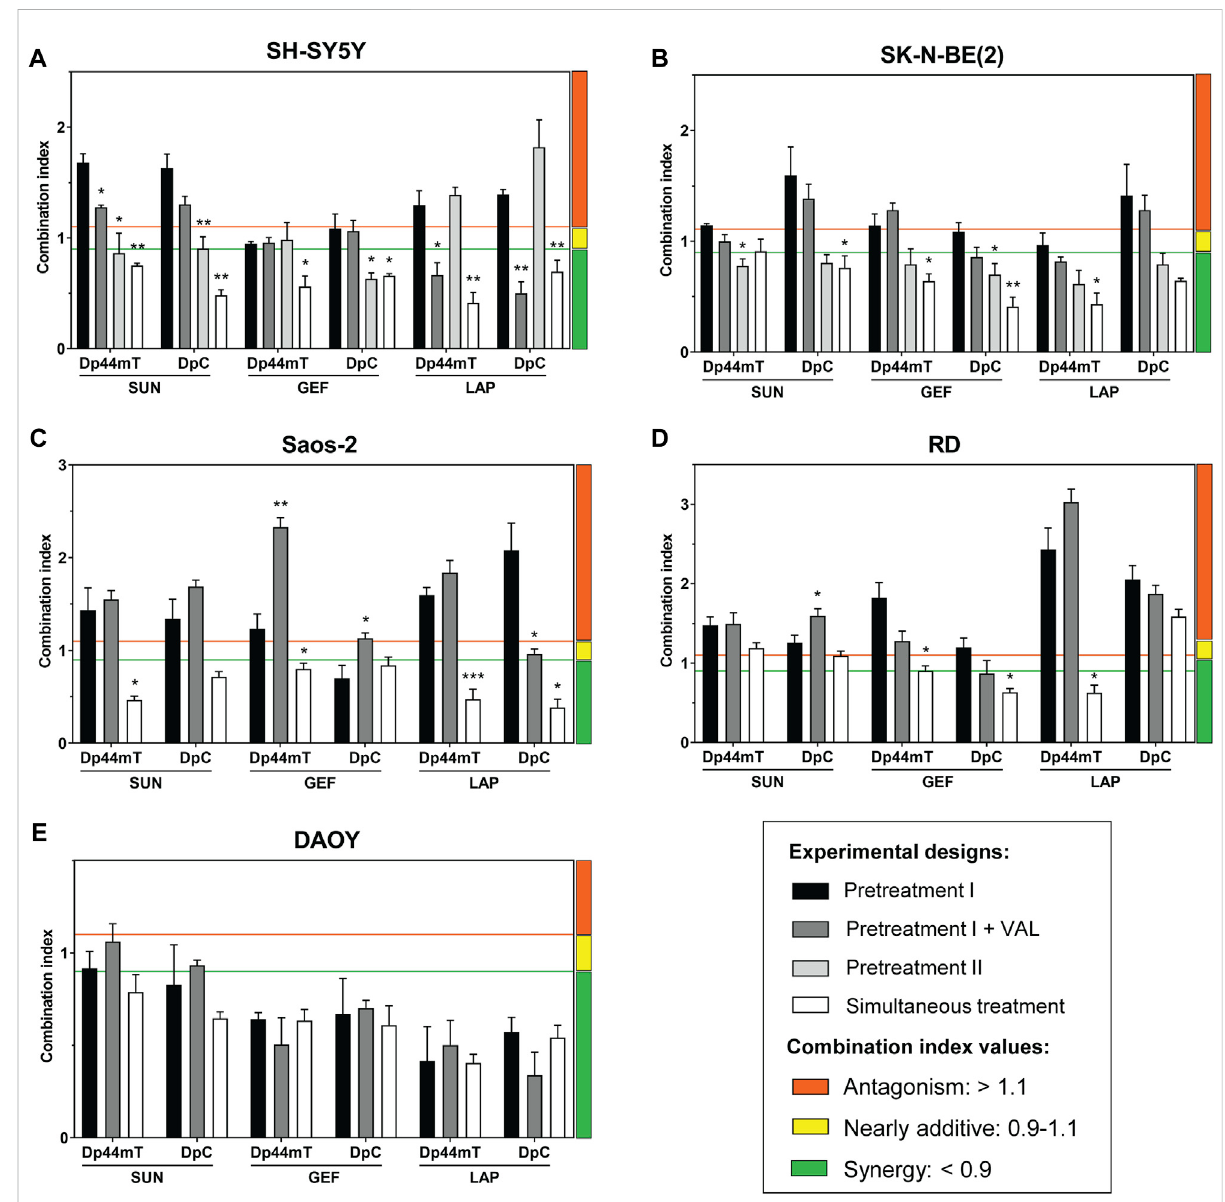
FIGURE 3 Combined treatments using thiosemicarbazones (Dp44mT and DpC) and TKIs (SUN, GEF, and LAP) of the cells derived from pediatric solid tumors. Combined treatments were evaluated in following cell lines (A) SH-SY5Y, (B) SK-N-BE(2), (C) Saos-2, (D) RD, and (E) DAOY. The drug combinationswereappliedusing ( i ) sequential(PretreatmentI,PretreatmentI+Valspodar(VAL),orPretreatmentII)or(ii)simultaneousexperimental designs (see Materials and Methods). IC 50 values that served to determine drug concentrations used in the respective combined treatment designs are listed in Table 2. The interactions between the corresponding drugs were evaluated as a combination index (CI) and were calculated based on the growth inhibition curves. A 1:1 ratio of the drugs and the Chou-Talalay method were used to identify the synergistic (green), nearly additive (yellow), or antagonistic activity (orange) using CalcuSyn Software. Columns represent the CI values ±SD ( n = 3). The data were analyzed usingone-wayANOVAfollowedbyDunnett ’ spost-hoctest.* p < 0.05,** p < 0.01and*** p < 0.0001indicatesigni fi cantdifferencescomparedtothe results obtained according to the Pretreatment I experimental